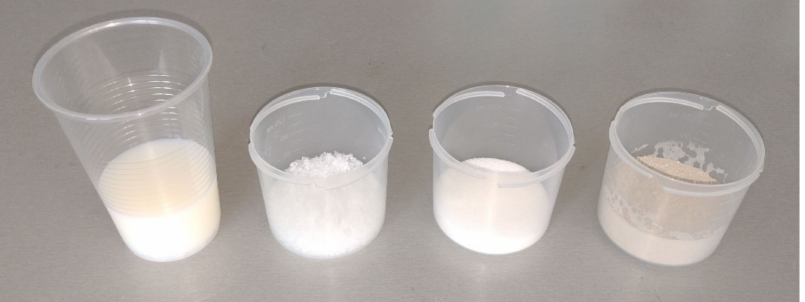
Figure 3. Accelerators involved in the research, from left: crystal seeds admixture, calcium nitrate, sodium hydroxide, CKD.